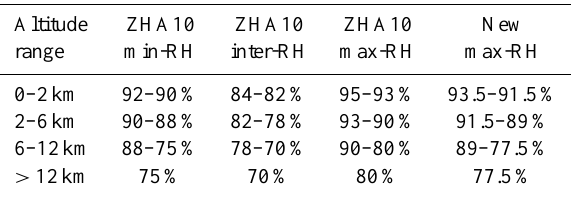
Table 3. Summary of the values for min-RH, inter-RH and max-RH from Zhang et al. (2010), and the new max-RH thresholds suggested for the low-resolution